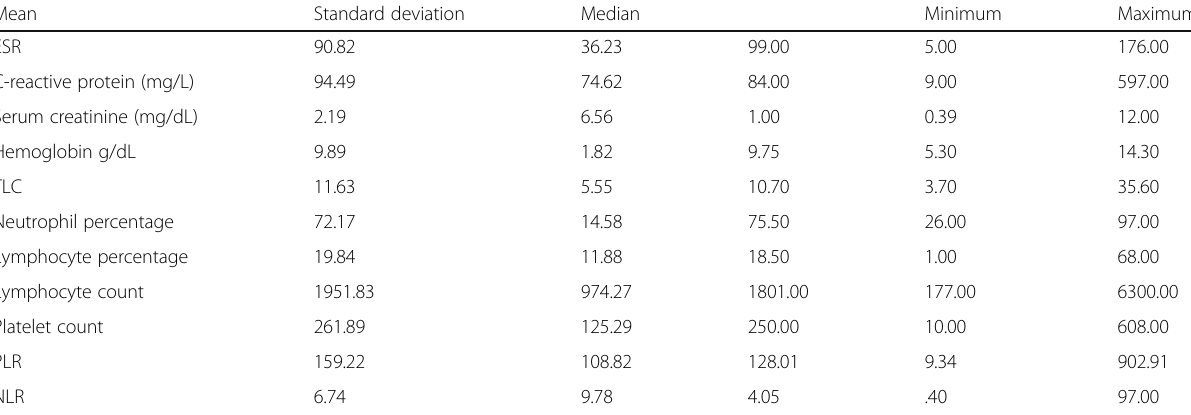
Table 1 Hematological and other laboratory characteristics of the patients Mean